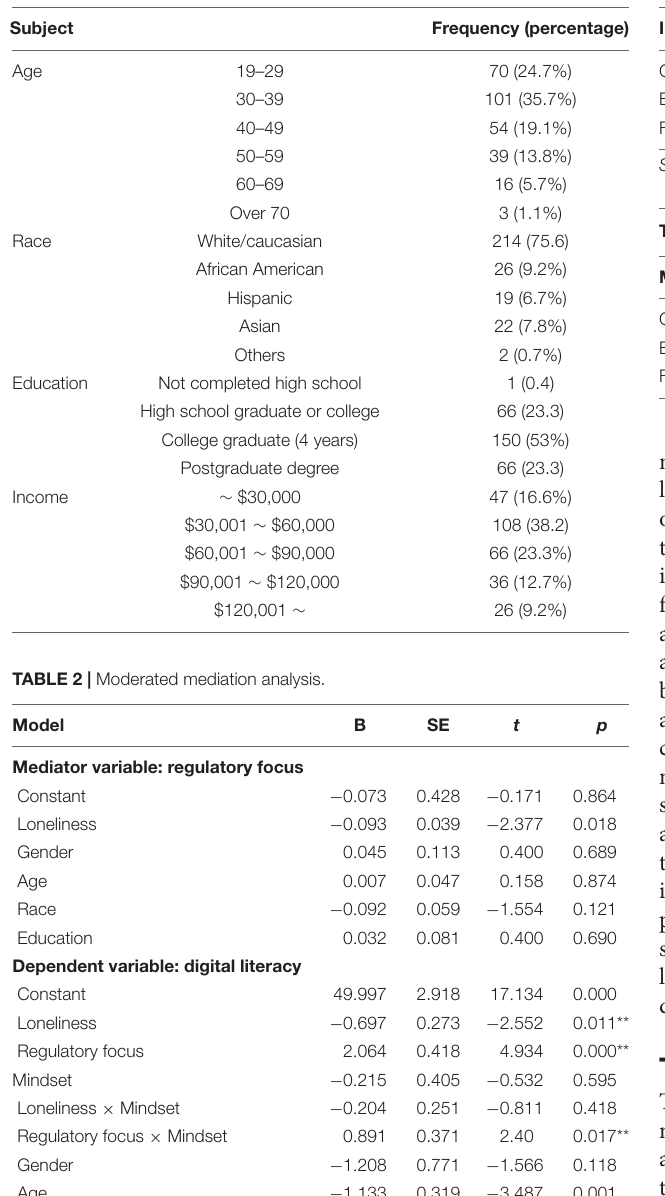
TABLE 3 | Conditional effect of the regulatory focus at values of mindset.